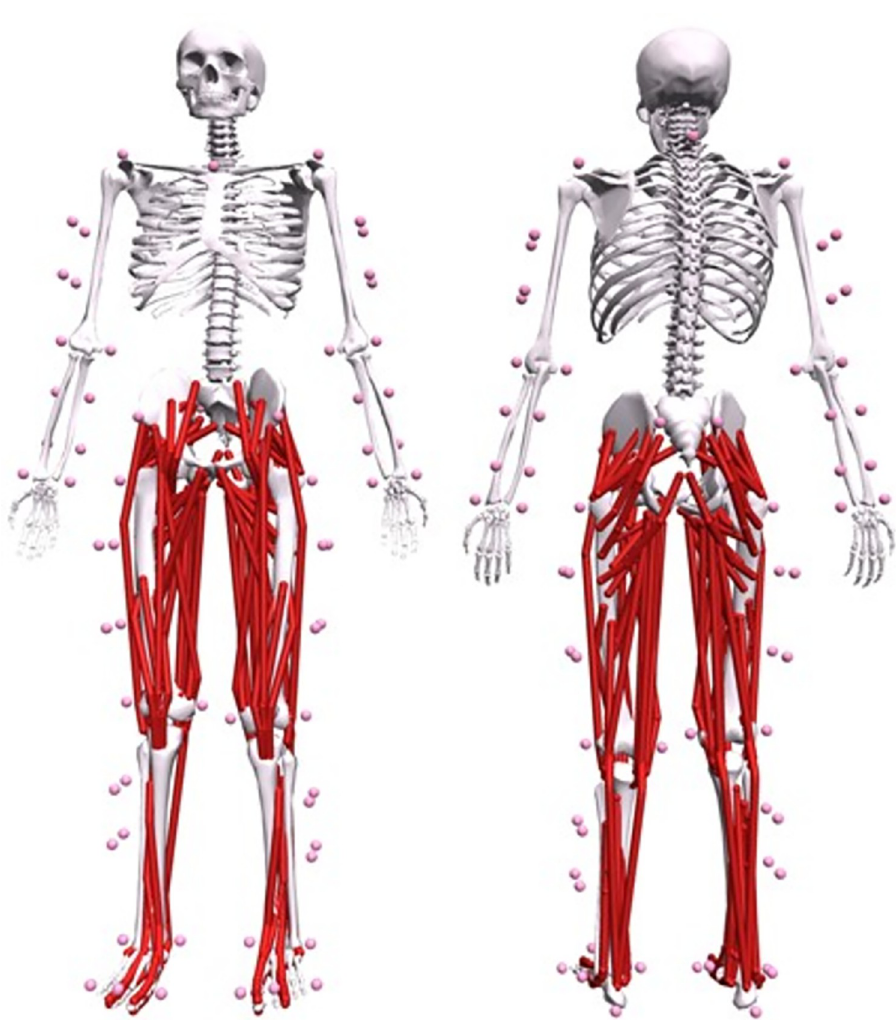
Fig 4. The OpenSim musculoskeletal model that will be used for the analysis (Lai et al. 2017 [65]). Red elements represent the muscle-tendon units, pink spheres represent marker placements on the